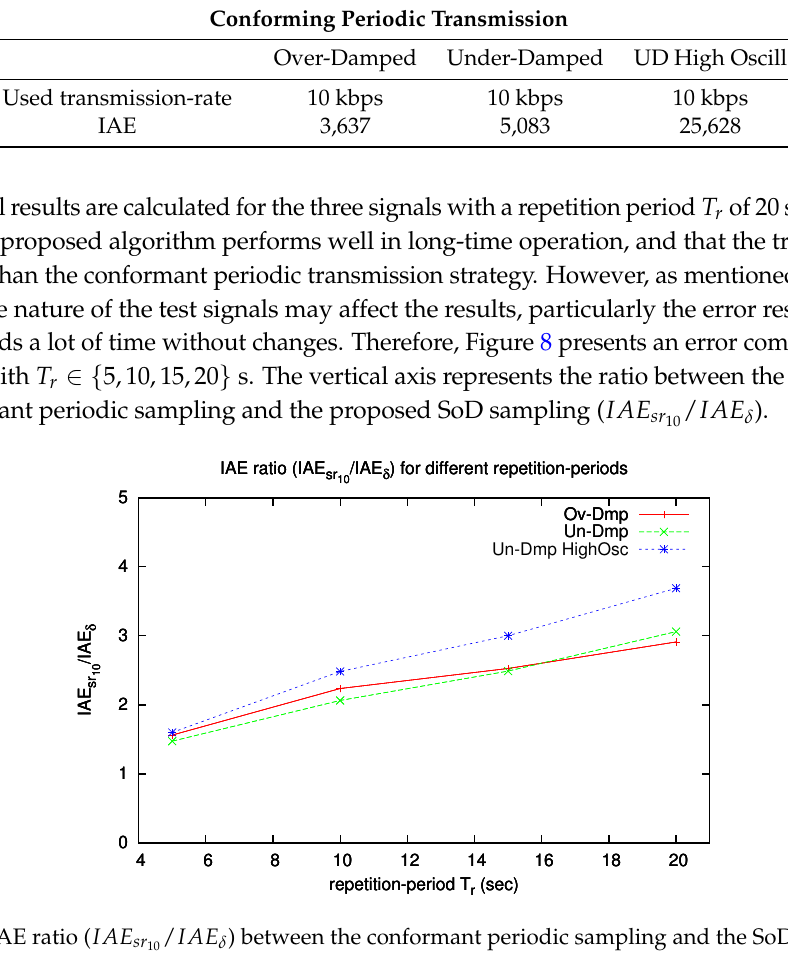
Figure 8. IAE ratio ( IAE sr / IAE δ ) between the conformant periodic sampling and the SoD sampling 10 for different repetition